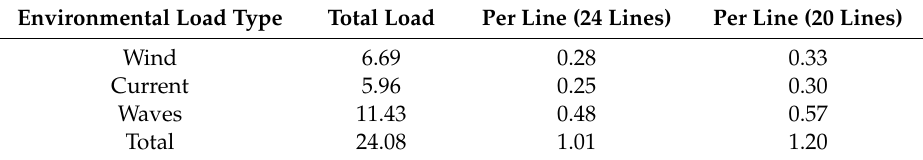
Table 1. Environmental loads calculated for an FPSO (magnitudes in MN).